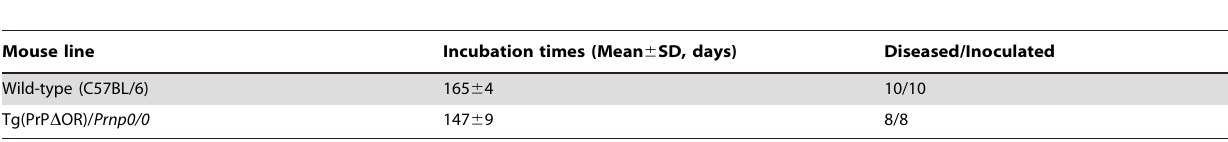
Table 1. Incubation times in tg(PrP D OR)/ Prnp 0/0 and wild-type mice after infection with RML prions.